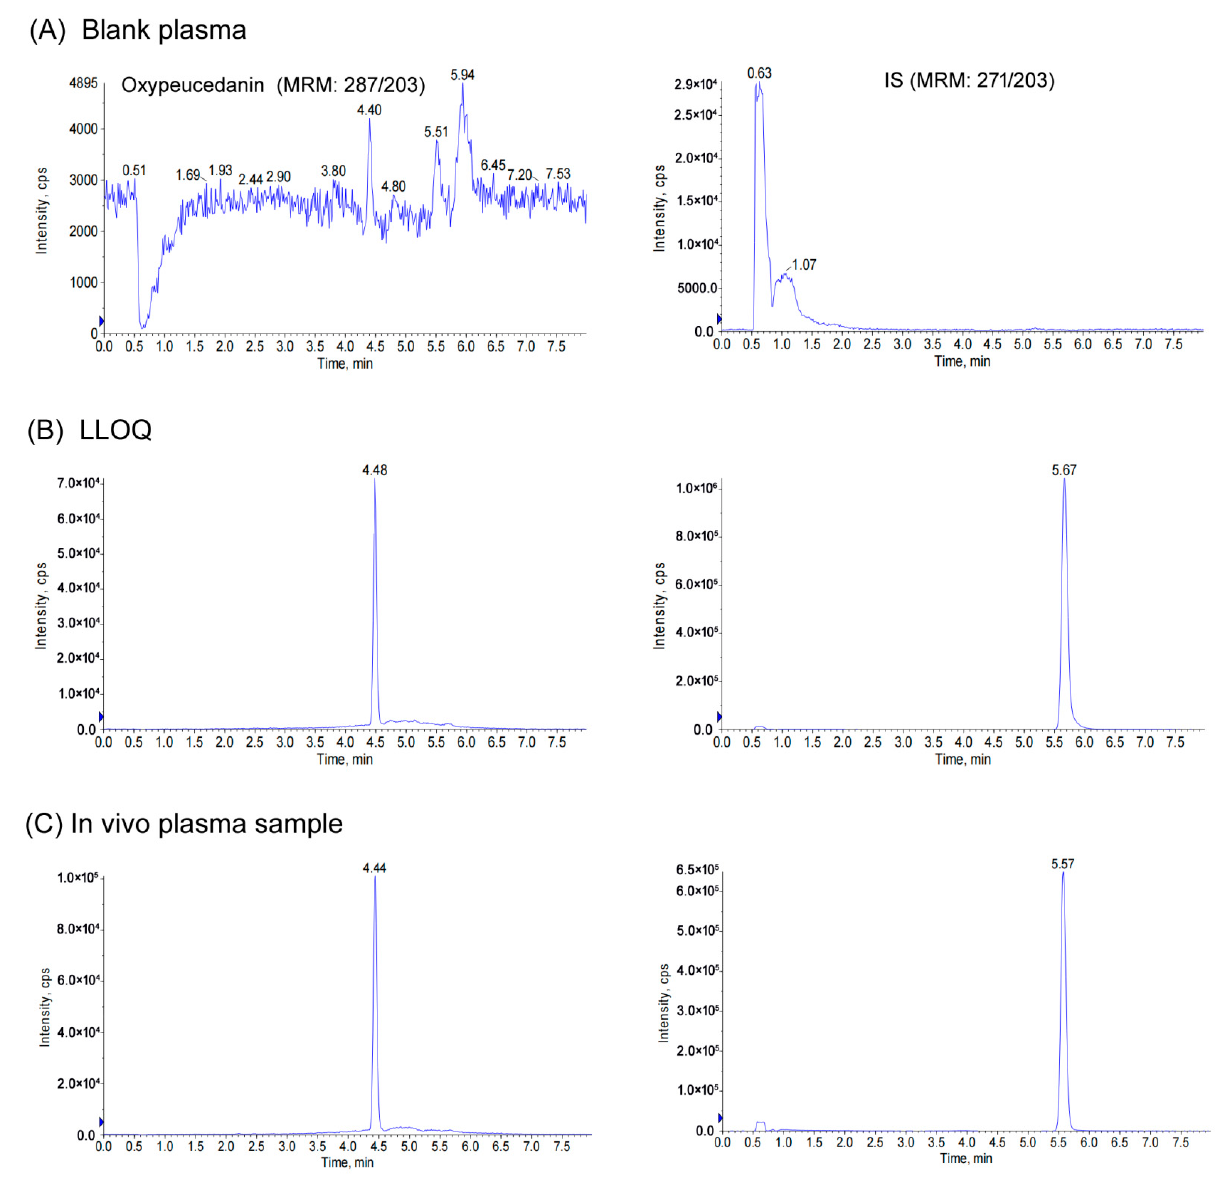
Figure 2. Representative MRM chromatograms of oxypeucedanin and IS in rat plasma: ( A ) blank plasma; ( B ) blank plasma spiked with oxypeucedanin at LLOQ level and IS; ( C ) an in vivo plasma sample collected at 12 h after oral administration of oxypeucedanin in rat at a dose of 20